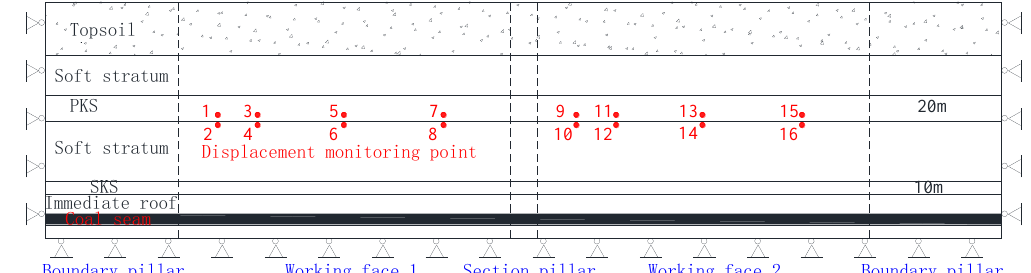
Figure 14. Numerical model configuration and displacement monitoring point locations.